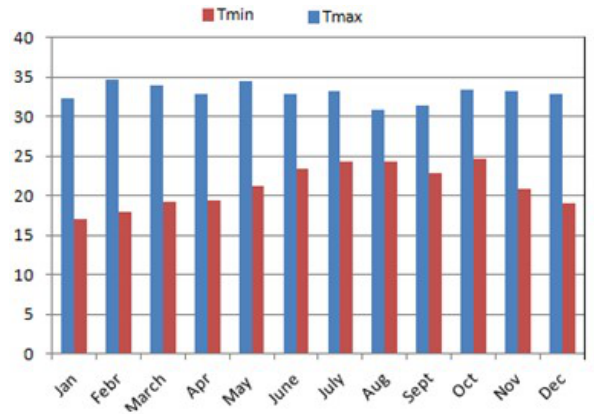
Figure 4: Annual variation of ambient maximal and minimal monthly temperatures of the Thies zone for years 2013, 2014 and 2013.